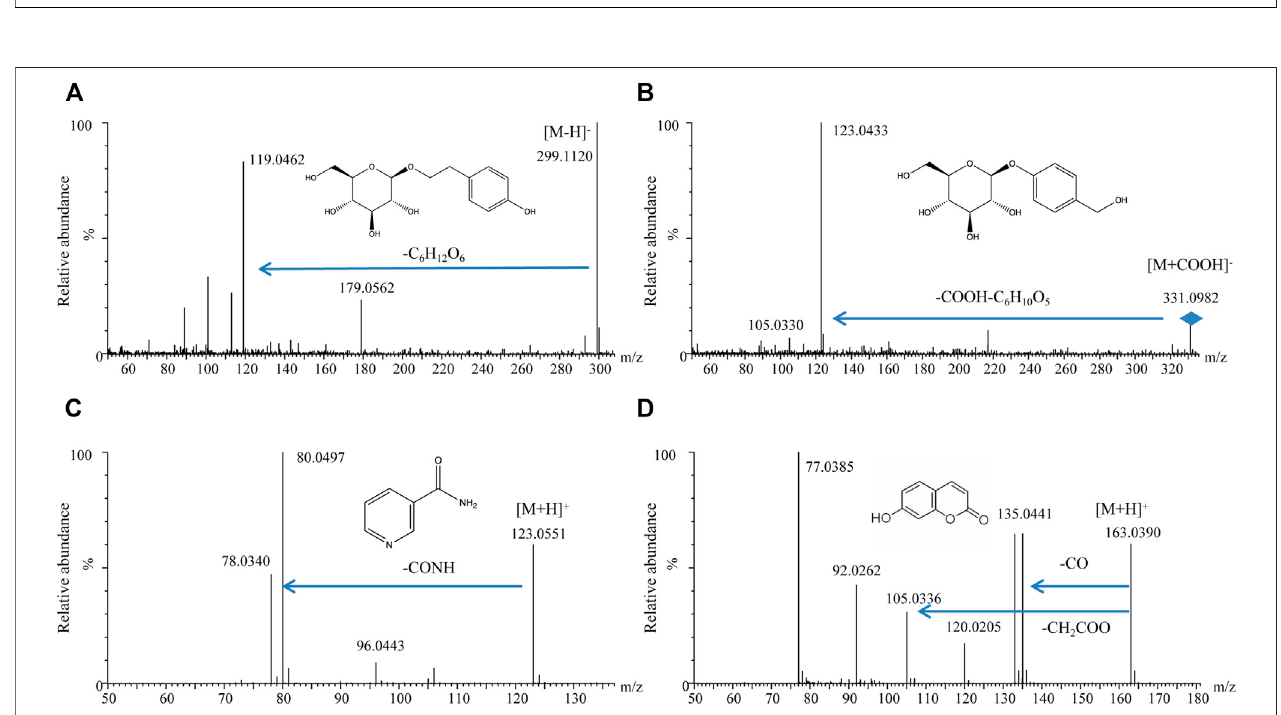
FIGURE 7 | MS 2 spectrograms of four compounds in rat plasma. (A) Salidroside; (B) gastrodin; (C) nicotinamide; (D) umbelliferone.